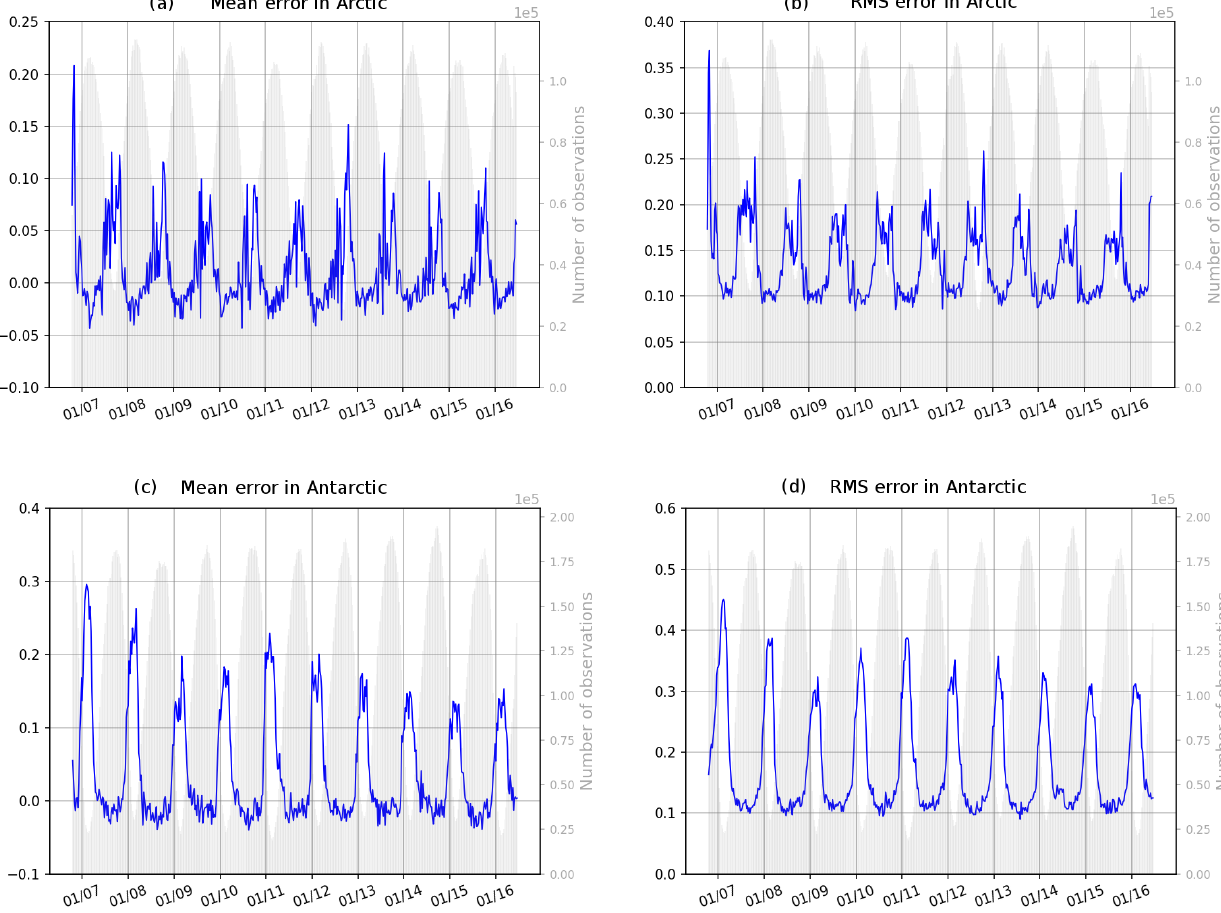
Figure 26. Time series of (observation–forecast) mean (a, c) and RMS (b, d) differences of sea ice concentration (0 means no ice, 1 means 100% ice cover) in the Arctic Ocean (a, b) and Antarctic Ocean (c, d) . The assimilated observations are the sea ice concentrations from OSI TAC. Time series of the number of available observations appear in